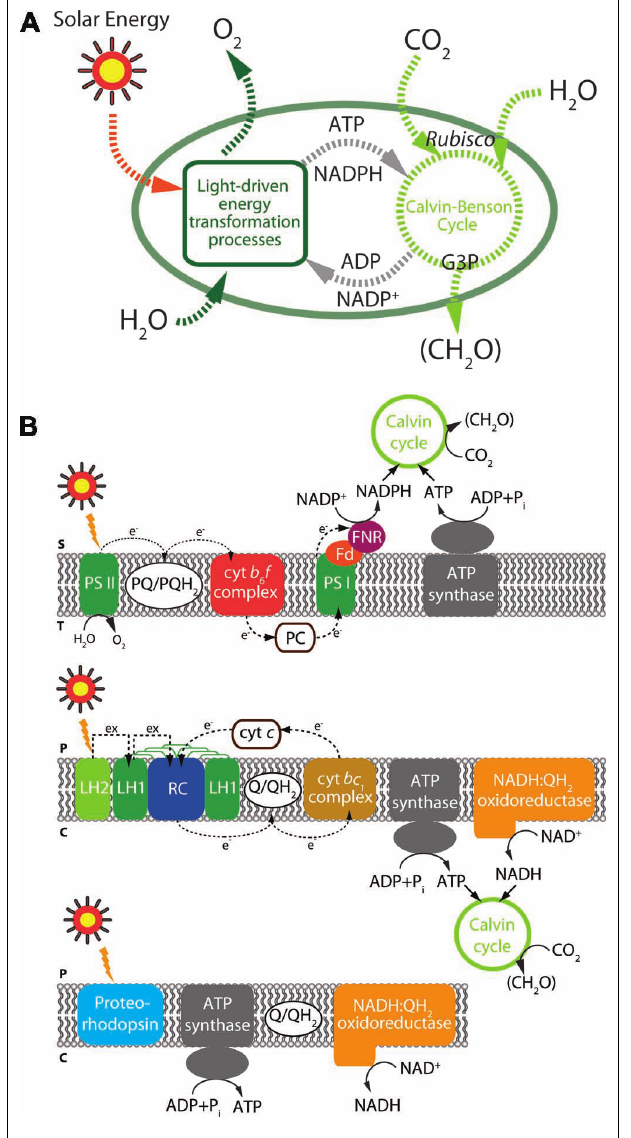
FIGURE 3 | Illustration of photosynthesis and carbon fixation (A) and key light-driven processes in microorganisms (B). Black solid and dashed arrows represent reactions catalyzed by each enzyme and electron flows, respectively. (Top panel) Overview of oxygenic photosynthesis from cyanobacteria. (Middle panel) Overview of anoxygenic photosynthesis from α -proteobacteria. (Bottom panel) Light-driven proton pump.The major components of photosynthesis and carbon fixation including elements are depicted: S, chloroplast stroma;T, thylakoid lumen; P, periplasm; C, cytoplasm; Cyt c , cytochrome c ; Cyt bc 1 , cytochrome bc 1 ; Cyt b 6 f , cytochrome b 6 f ; Fd, ferredoxin; FNR, ferredoxin-NADP + reductase; LH, light-harvesting complex; PC, plastocyanin; PS, photosystem; PQ, plastoquinone; Q, ubiquinone; QH 2 ,